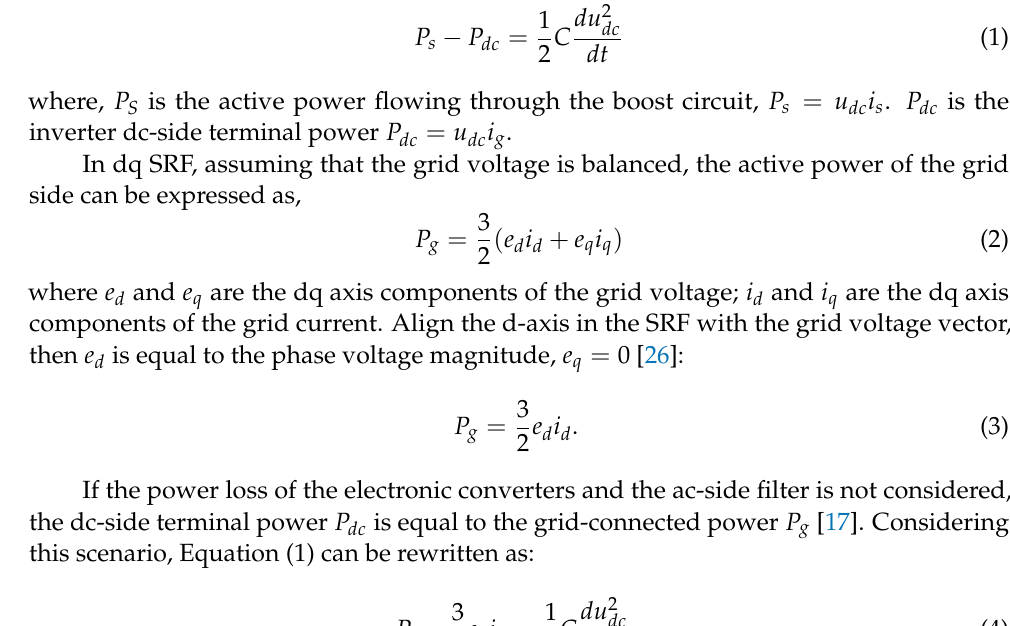
Figure 1. Configuration and power flow of two-stage PV grid-connected system, where C denotes the dc-link capacitor; u denotes the dc-link voltage; i s is the output current of the boost converter; i dc is the current flowing through the dc-link capacitor; i g is the current input to the inverter by the dc link; i a , i b , i c , represent the grid phase current; e a , e b , e c represent the phase voltage of the grid; R and L represent the filter resistance, and inductance,